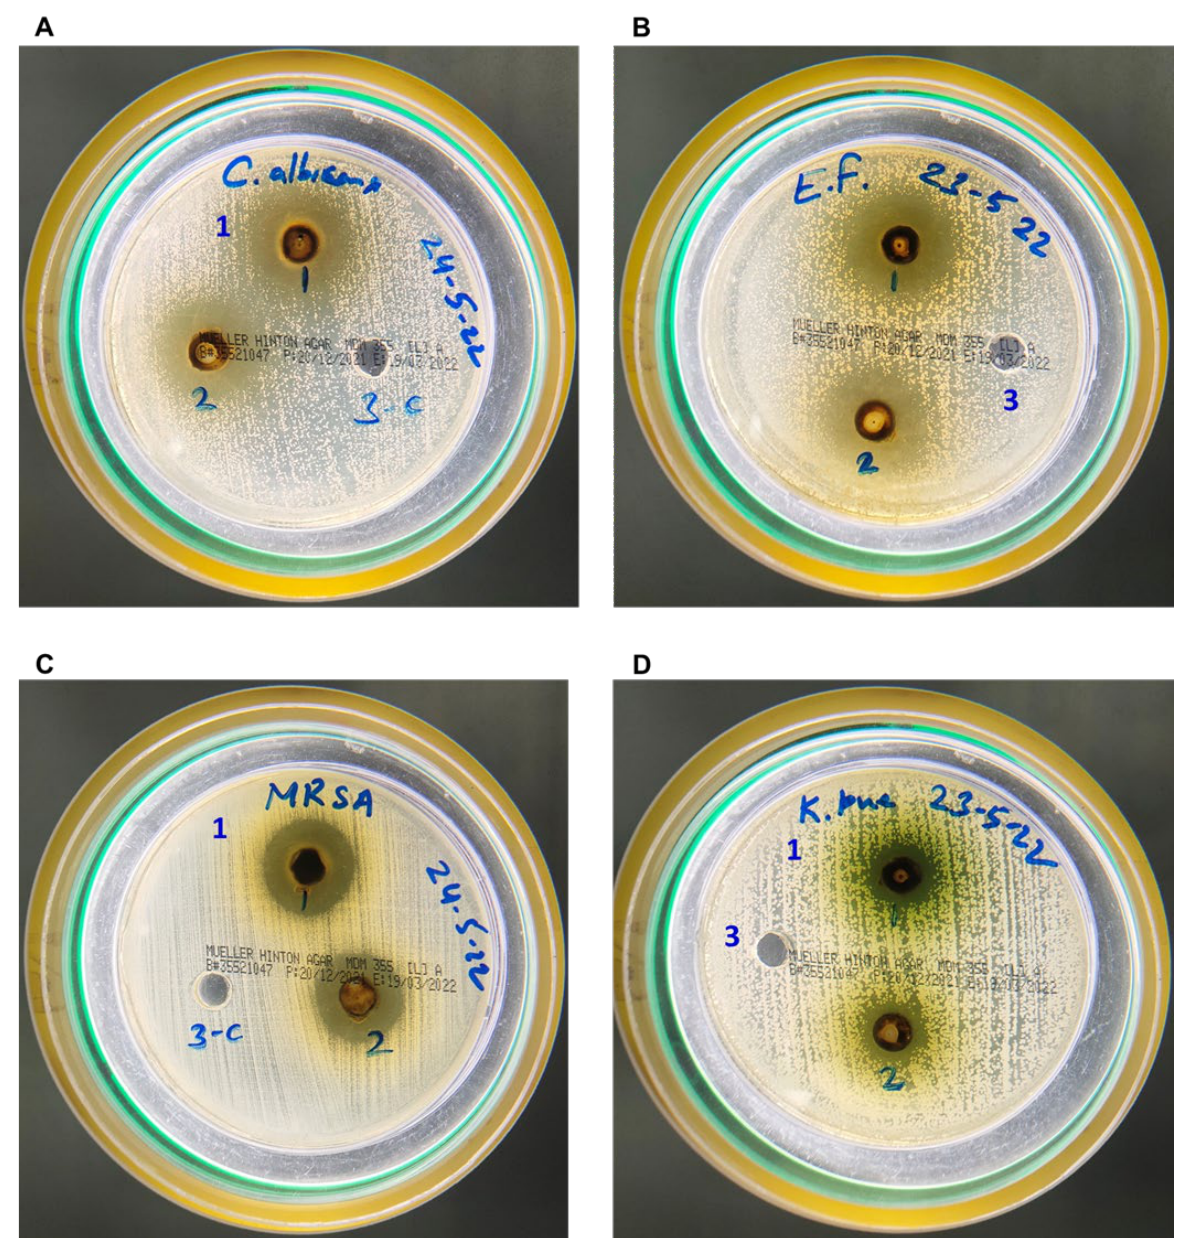
Figure 2. AAE shows antimicrobial activity against ( A ) C. albicans , ( B ) E. faecalis , ( C ) MRSA, and ( D ) K. pneumoniae .